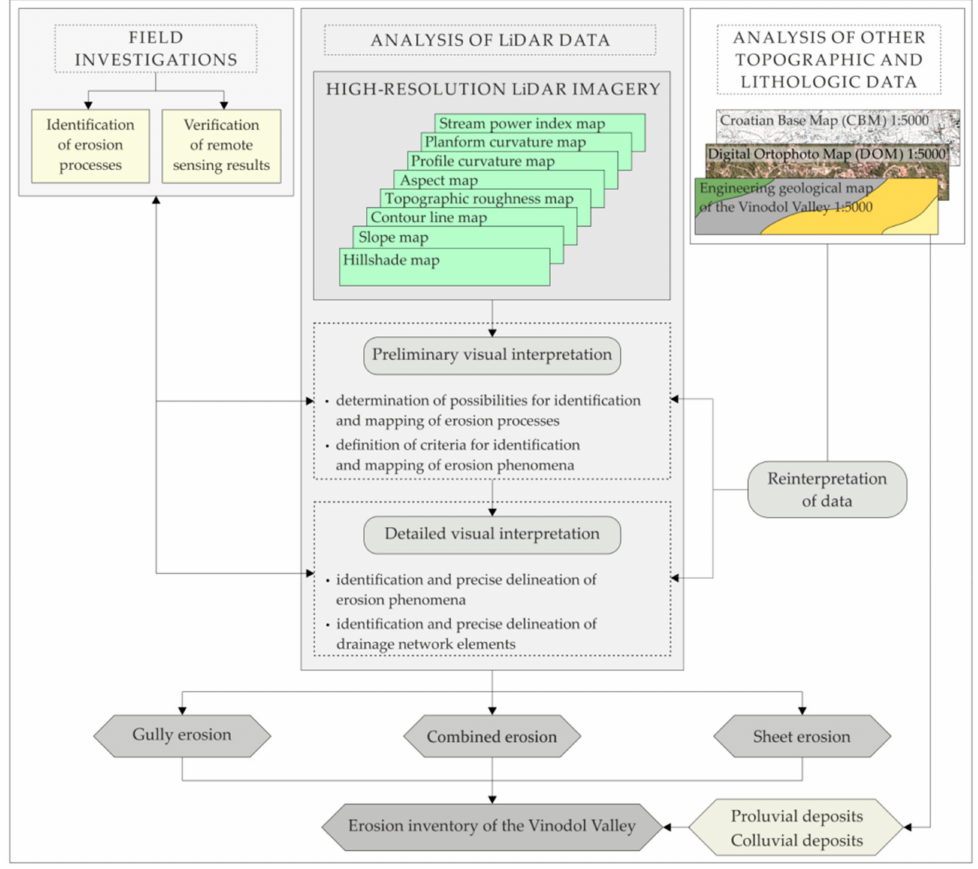
Figure 4. Flowchart of the methodology for the preparation of the erosion